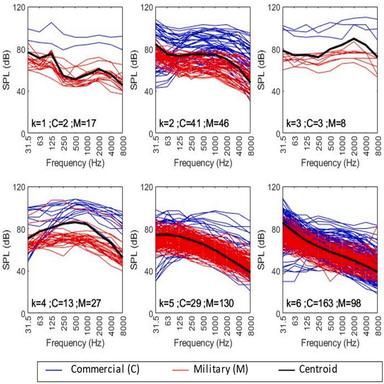
Spectrum classification in 6 clusters arranged by k value, by unsupervised machine learning algorithm k-means.